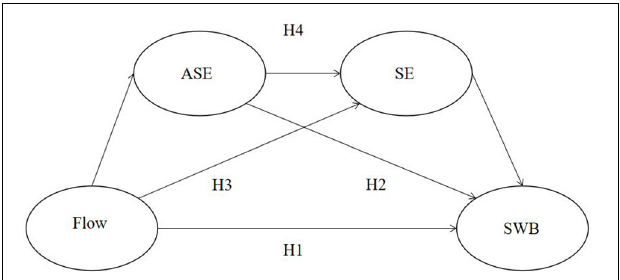
FIGURE 1 | Proposed conceptual model. ASE, academic self-efficacy; SE, self-esteem; SWB, subjective well-being; H1, Flow-SWB; H2, Flow-ASE-SWB; H3, Flow-SE-SWB; H4,